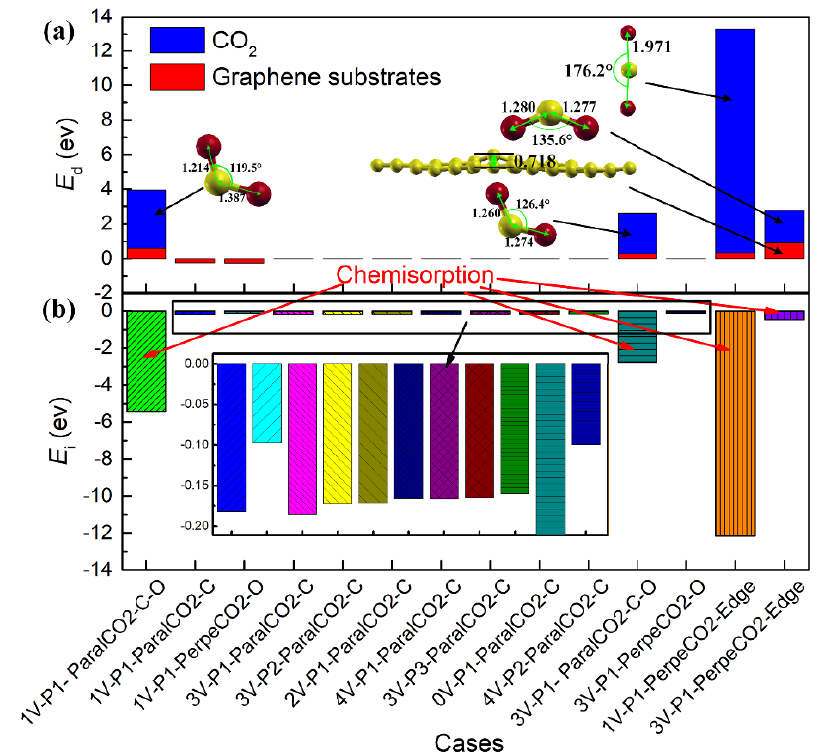
Figure 4. Deformation energy and interaction energy: ( a ) the deformation energy of graphene substrates and CO 2 after adsorption process; ( b ) the interaction energy between the graphene substrates and adsorbed CO 2 .